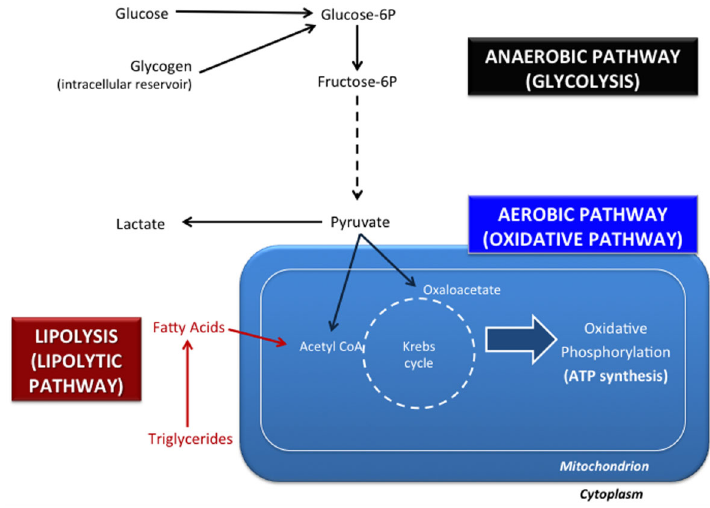
Figure 1. Essential metabolic pathways for bovine embryonic development. The anaerobic pathway (glycolysis or the glycolytic pathway) does not utilize oxygen and generates lactate. Glucose, one of the most important metabolic substrates for glycolysis, is obtained from the extracellular medium or from glycogen reser- voirs. In the aerobic (or oxidative) pathway, pyruvate is converted into oxaloacetate or acetyl-CoA and fatty acids are converted into acetyl-CoA. ATP synthesis is dependent on the Krebs’ cycle and on oxidative phosphorylation (enzymatic reactions catalyzed by proteins from the inner mitochondrial membrane). The lipolytic pathway (or lipolysis) allows the oxidation of fatty acids, obtained from lipid (triglyceride) reservoirs or from the extracellular